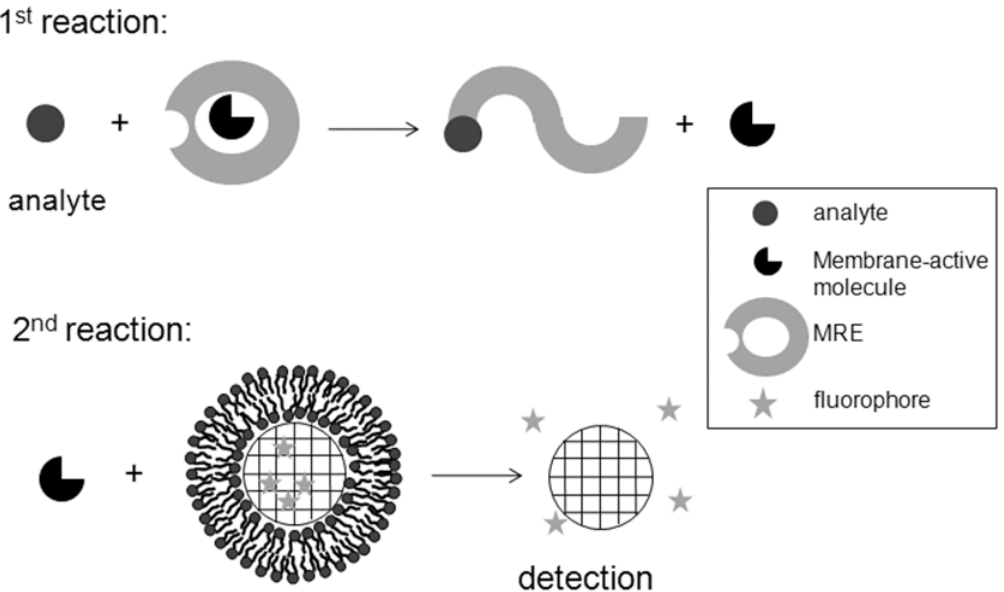
Figure 9. Schematic of a proposed general design that employs biomimetic microspheres for biosensing of analytes that do not interact with biomembranes. This design involves indirect detections with two-step reactions. The first one releases a membrane-active molecule as a result of interaction of the analyte with its MRE. The second reaction detects the released membrane-active molecule after interacting with SLBs on biomimetic microspheres. Fluorimetric detection is shown here as an